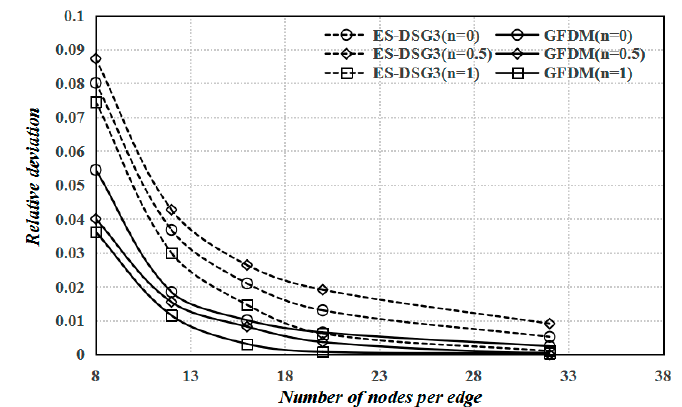
Figure 8. The relative deviation, based on the IGA [39] in Table 2 versus 8 × 8, 12 × 12, 16 × 16, 20 × 20, and 32 × 32 nodes (grids), including the finite element method, with node-based strain smoothing [38] and the present method.